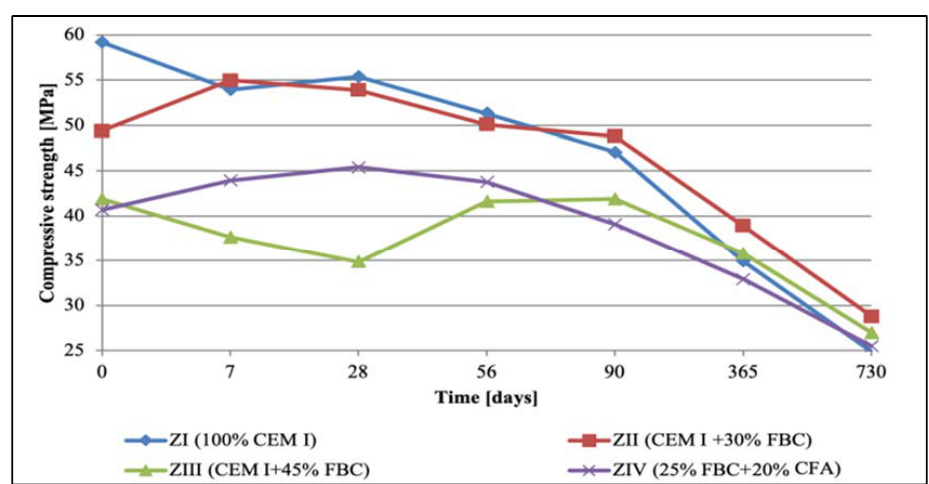
Figure 8. Compressive strength of mortars cured for 730 days in 1% solution of hydrochloric acid with pH = 2. The analysis of data presented in Figure 9 shows that up to 56 days of curing in the aggressive environment, the mortars’ strengths stayed more or less at the same level, whereas the highest drop in their strength was observed between the 90th and 365th day